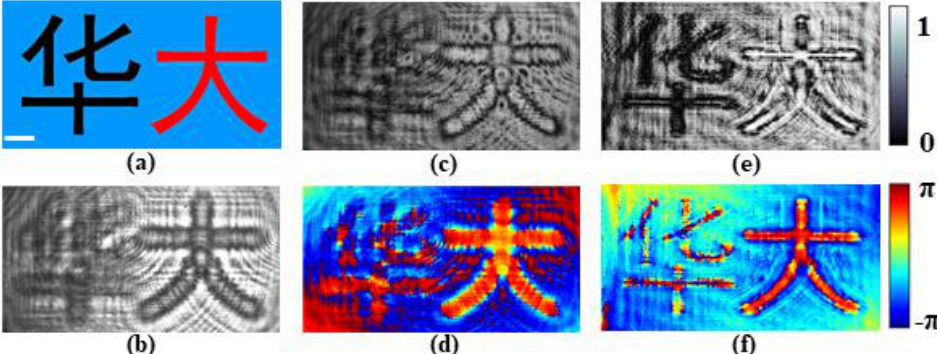
Figure 3. Complex field reconstruction results: ( a ) complex-valued object encoded in the SLM; ( b ) single-shot intensity of hologram recorded; ( c ) retrieved amplitude distribution at the sensor plane; ( d ) retrieved phase distribution at the sensor plane; ( e ) reconstructed amplitude distribution at the object plane; ( f ) reconstructed phase distribution at the object plane. Scale bar is 1.0 mm.